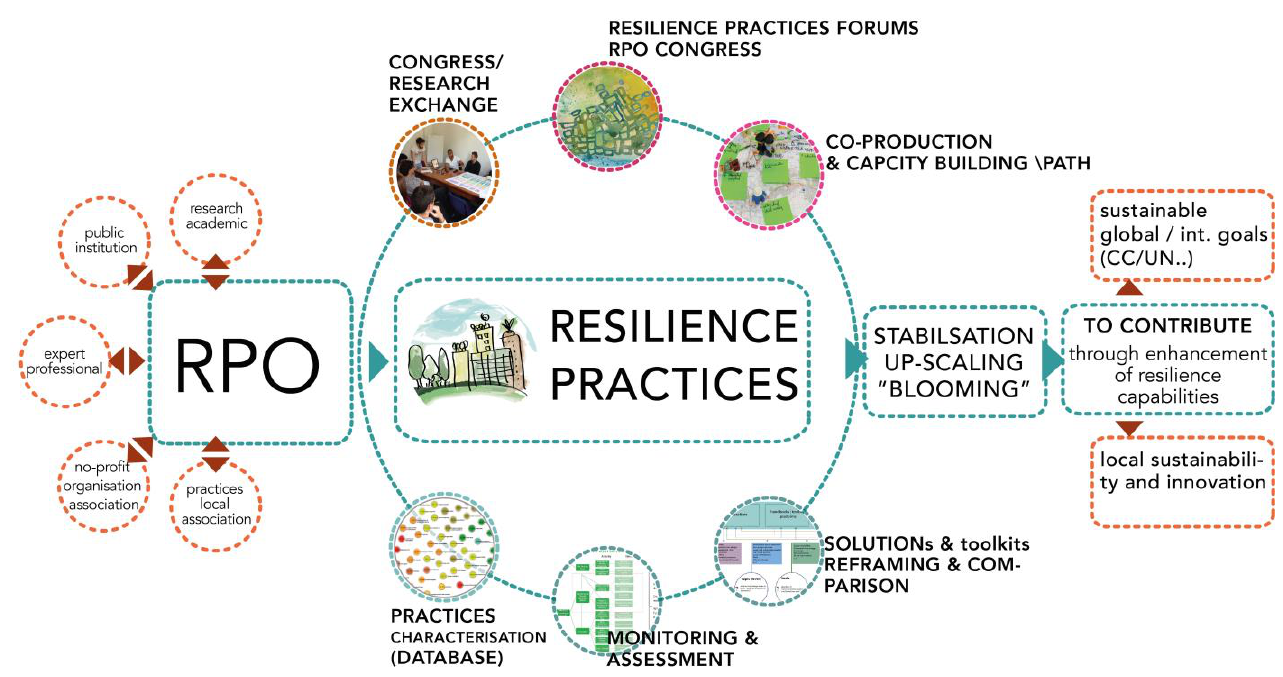
Figure 2. Resilience Practices Observatory project: goals and multiple research-action activities launched.